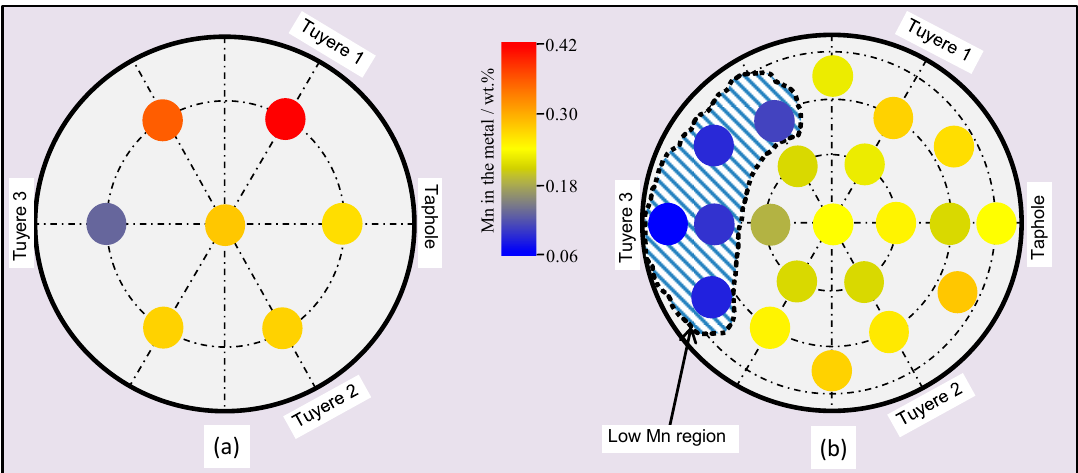
Figure 7. Distribution of C and Si in the metal samples from the EBF hearth: (a) C in the metal; (b) Si in the metal.